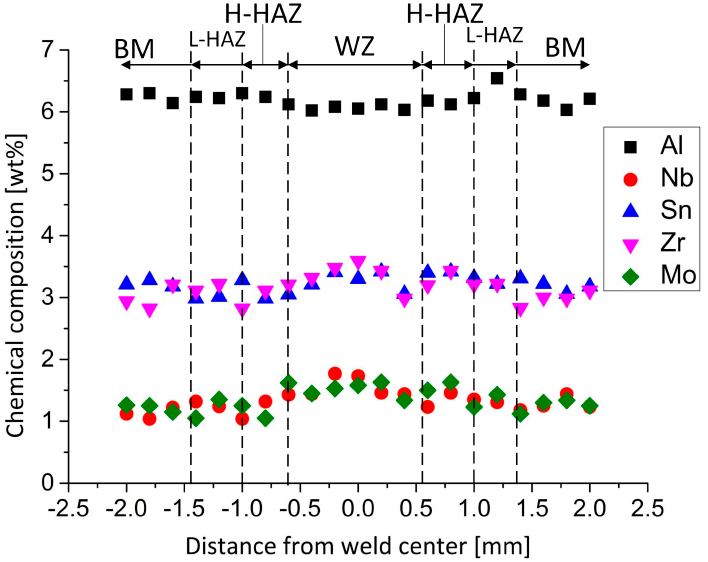
Figure 5. Chemical composition of BTi-6431S laser weld joint.